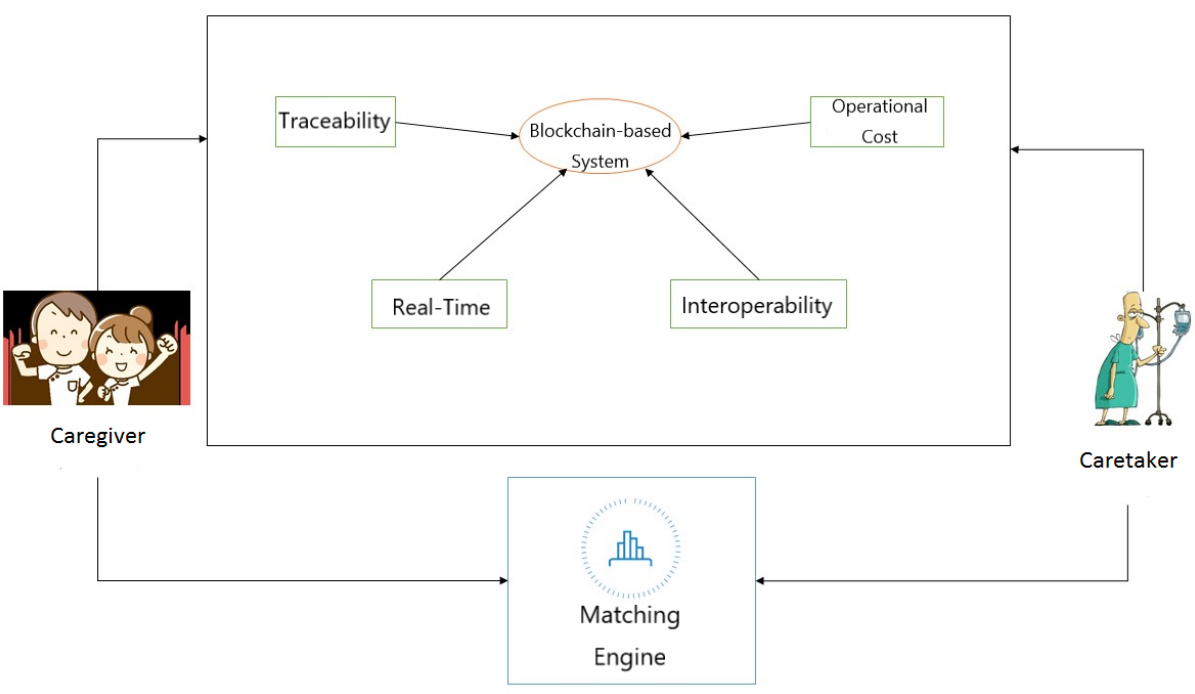
Figure 2. The role of blockchain in improving the home care service